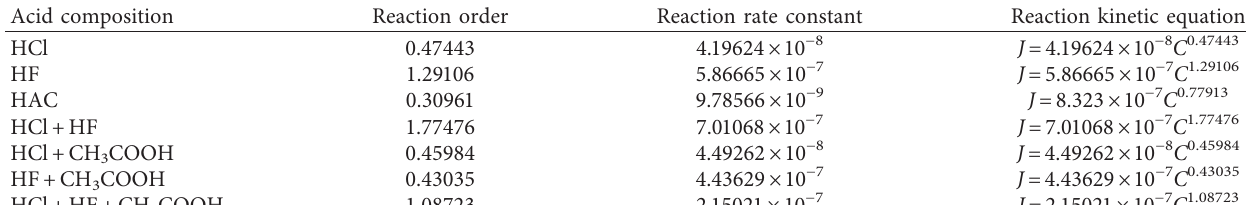
Table 2: Statistics of experimental results of acidified sodium bentonite in different acid systems. Acid composition